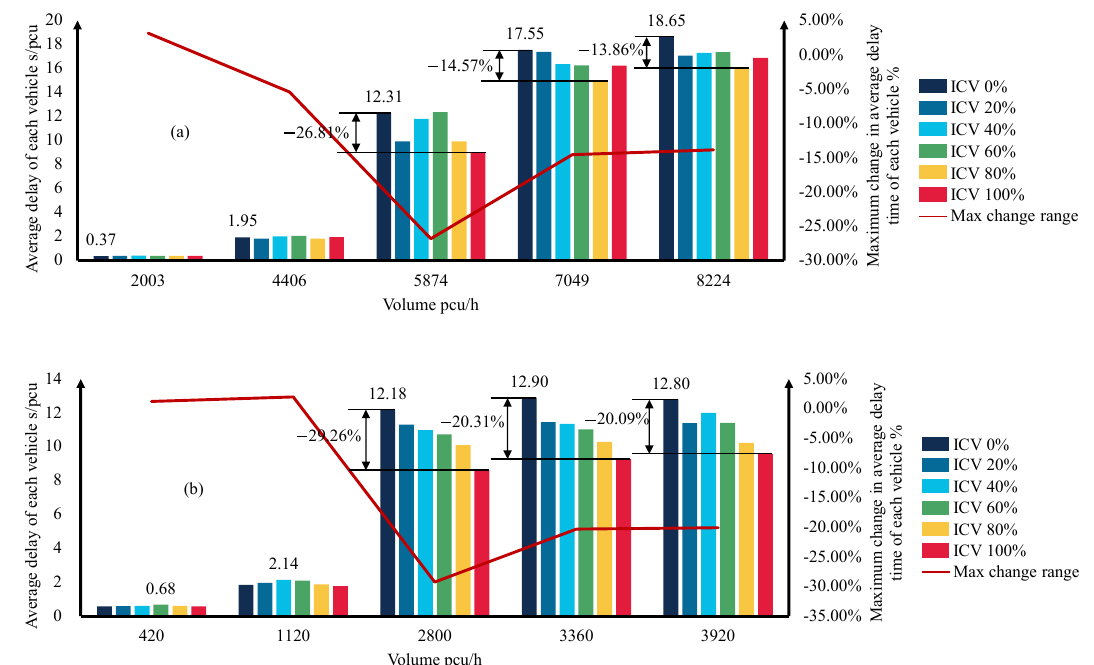
Figure 1. The impacts of SLADS on traffic delay on the expressway ( a ) and the secondary motorway ( b